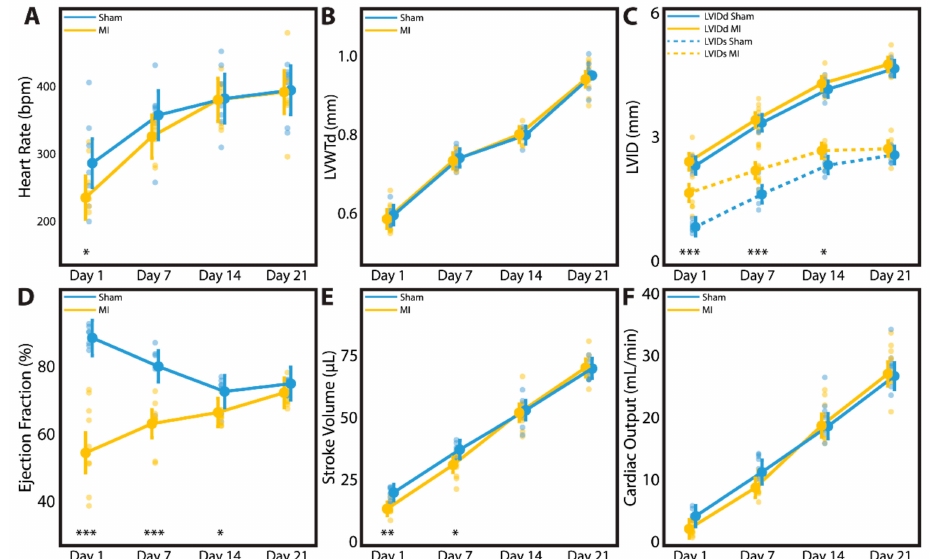
Figure 8. Time-course echocardiography was performed for neonatal rats at 1 day, 1 week, 2 weeks, and 3 weeks after sham surgery ( n = 7) or induction of myocardial infarction (MI, n = 9) on postnatal day 1. Parameters studied include ( A ) heart rate, ( B ) left ventricular wall thickness in diastole (LVWTd), ( C ) left ventricular internal diameter in diastole (LVIDd) and systole (LVIDs), ( D ) ejection fraction, ( E ) stroke volume, and ( F ) cardiac output. * indicates p < 0.05. ** indicates p < 0.01. *** indicates p < 0.001. Large dots indicate mean. Small dots represent individual data points. Vertical lines indicate 95% confidence